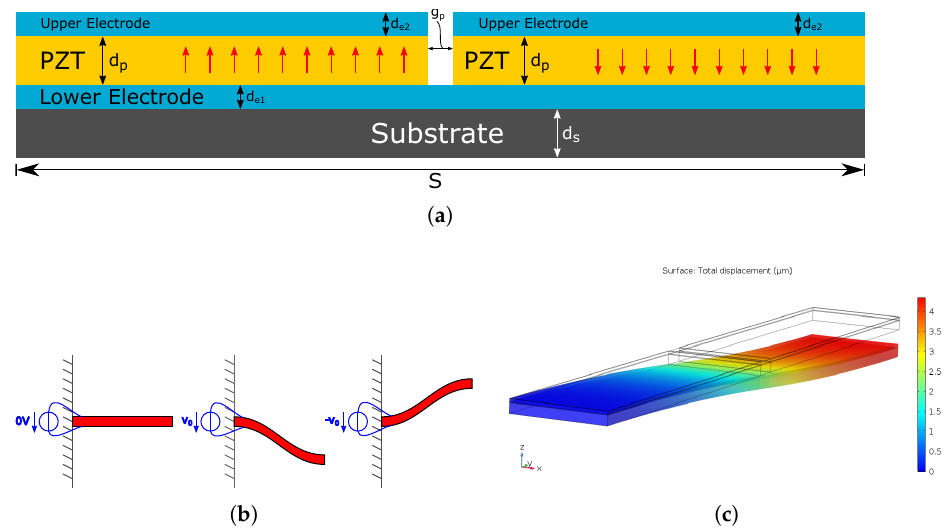
Figure 8. ( a ) Layered structure of the piezoelectric cantilever actuator with indicated polarisation direction (red arrows), ( b ) resting position and staircase flexural mode showing when applying different voltages between upper and lower electrode, and ( c ) COMSOL simulation of the displaced cantilever (displacement